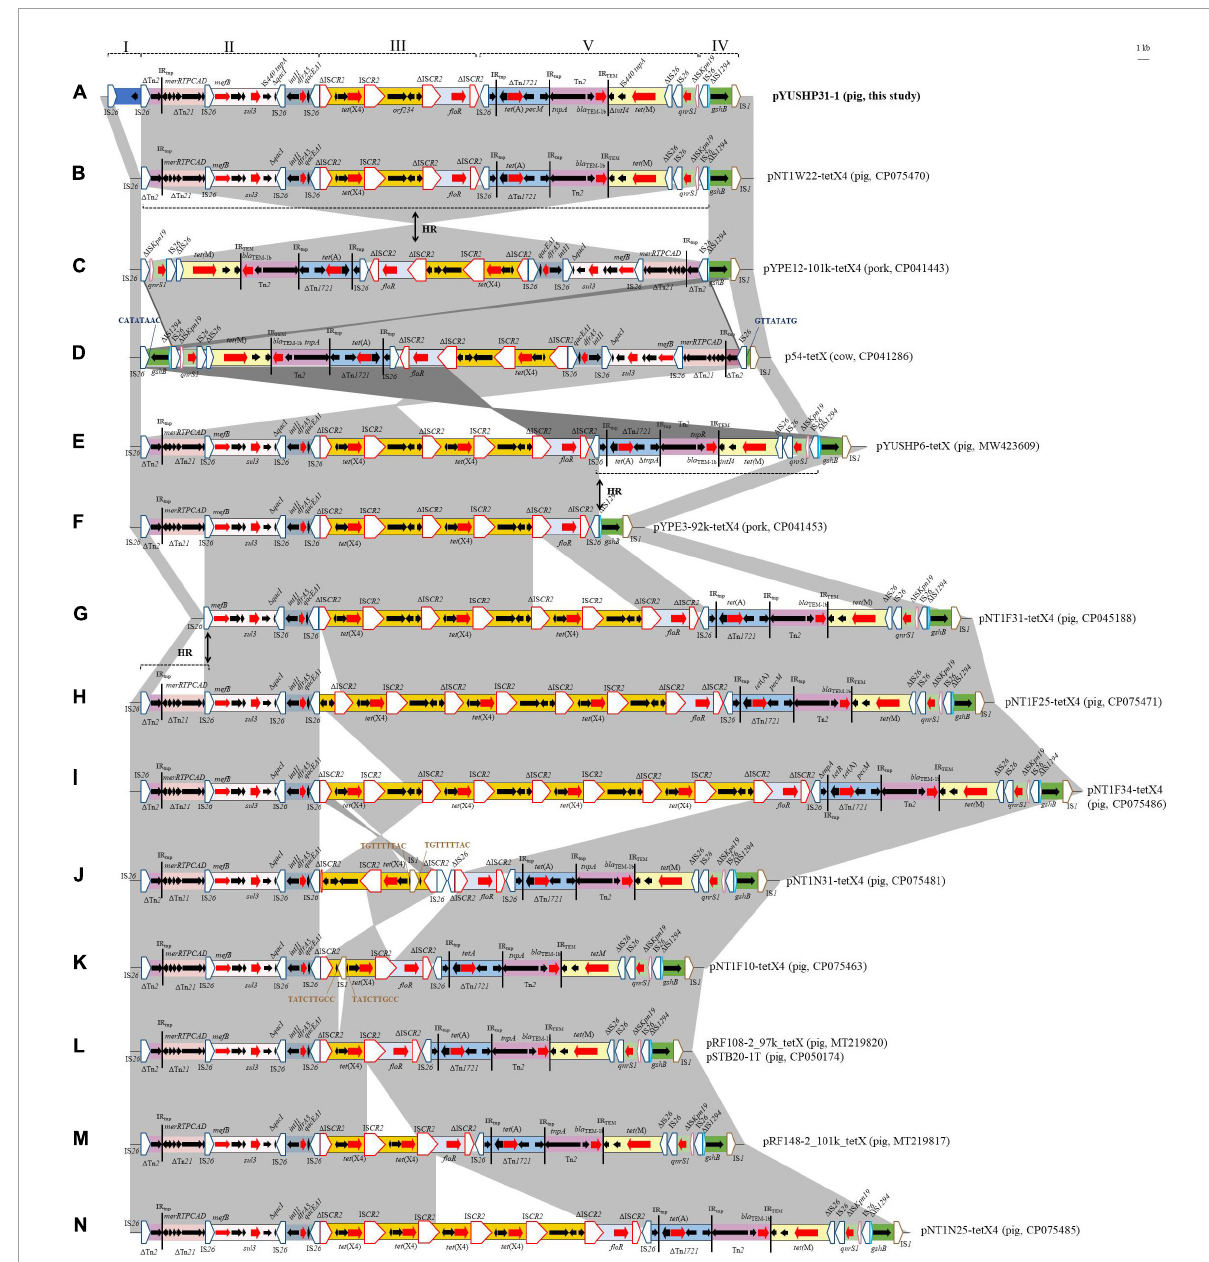
FIGURE3 Genetic organization of the multidrug resistance region of plasmid pYUSHP31-1 and structural comparison with other IncFIA18/IncFIB(K)/IncX1 plasmids. I to IV indicate five regions bounded by IS26 or ISCR2 in pYUSHP31-1. The extents and directions of orientation of resistance genes (thick red arrow) and other genes are indicated by arrows. Regions with > 99% identity are shaded in gray. 1 indicates a truncated gene or mobile element. Insertion sequences (ISs) are shown as boxes labeled with the IS name. Labeled vertical arrows with IS boxes denote the insertion position of IS elements. Direct repeats are indicated by arrows and sequences. Tall bars represent the 38-bp IR of transposons (Tn). Arrows labeled with “HR” and dotted lines indicate where homologous recombination could explain differences between